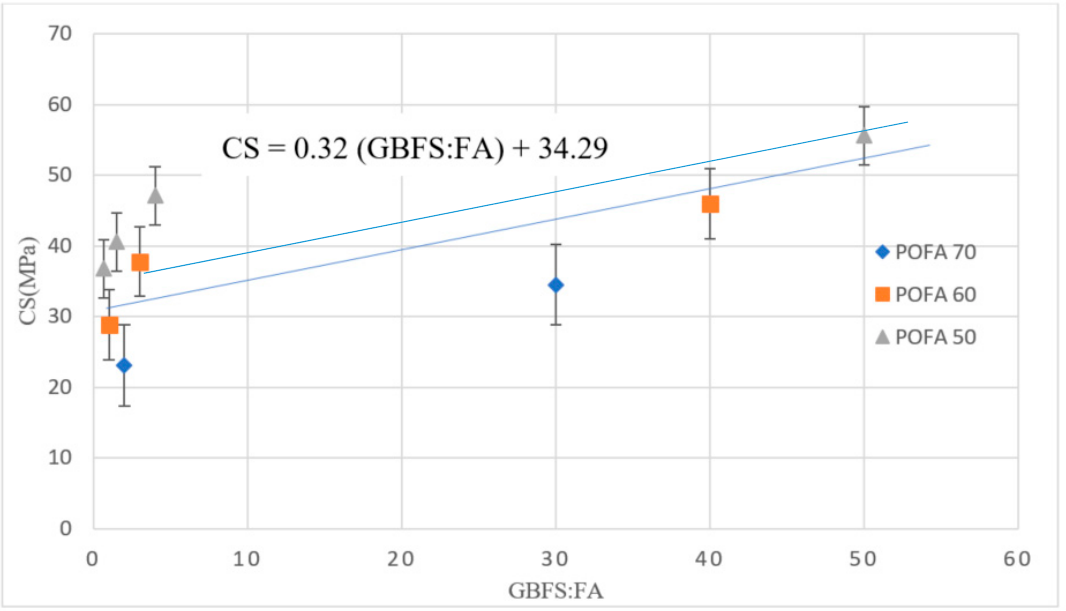
Materials 2020 , 13 , x FOR PEER REVIEW Figure 4. CS of AAM designs with a high volume of POFA. Figure 4. CS of AAM designs with a high volume of POFA.